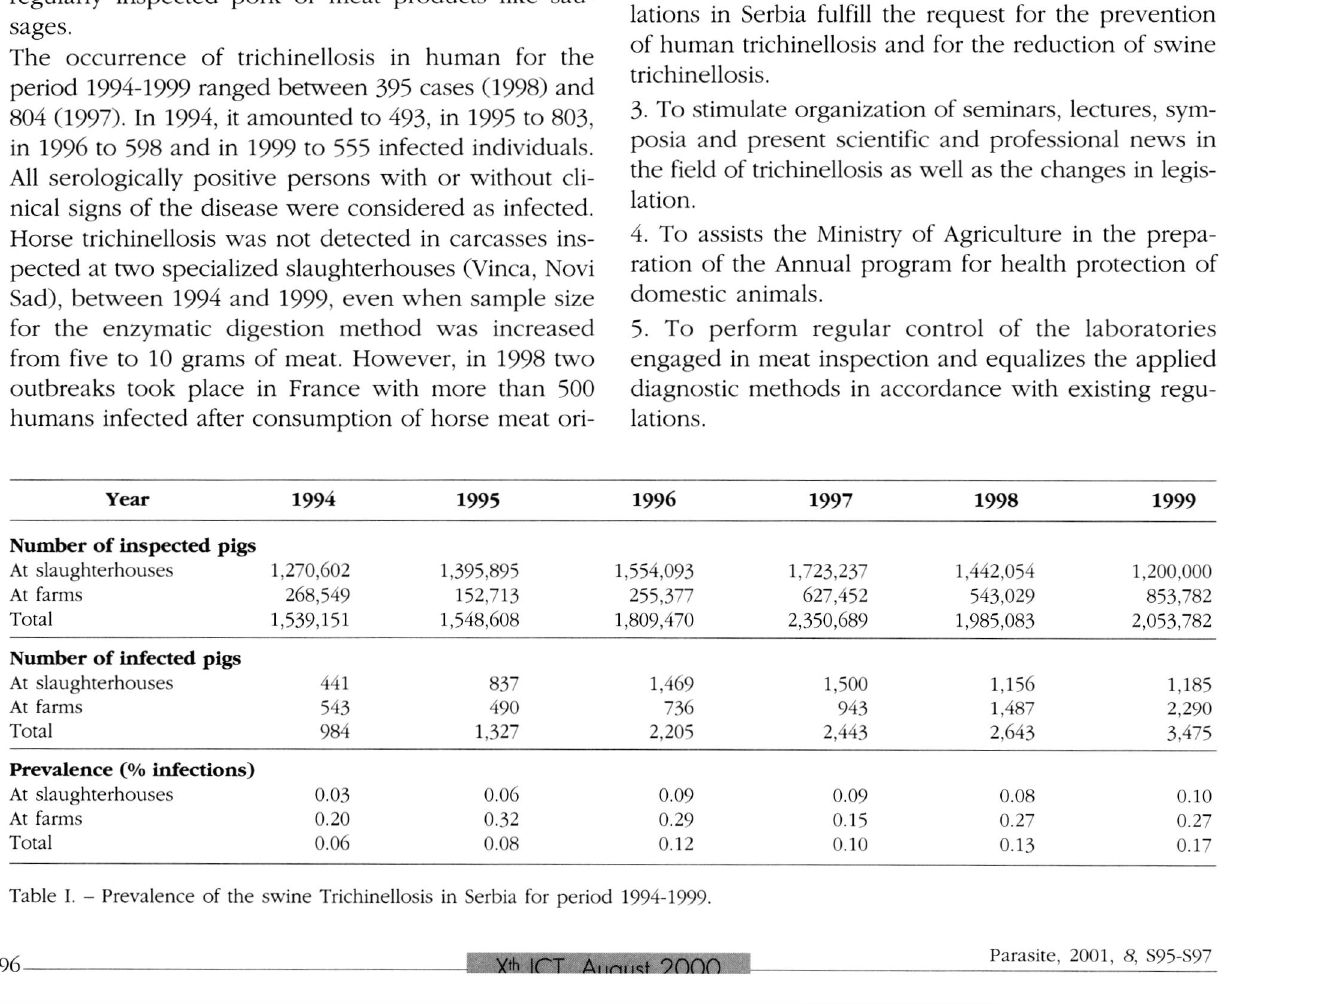
Table I. - Prevalence of the swine Trichinellosis in Serbia for period